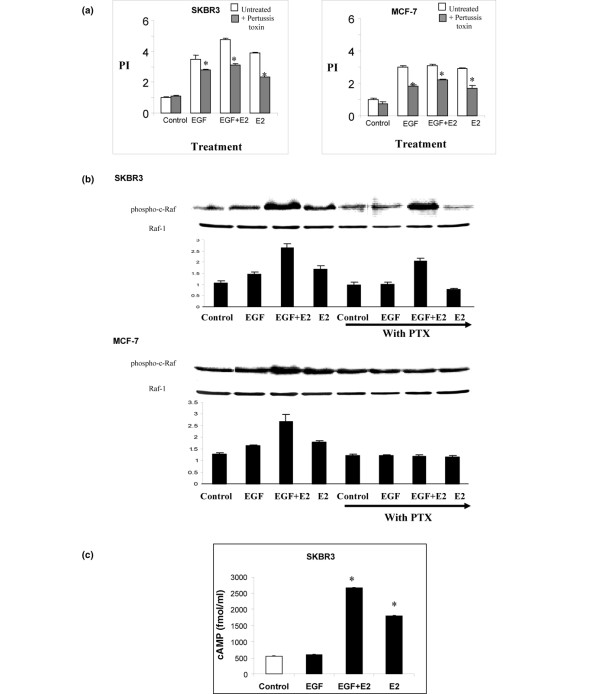
Effect of GPCR antagonism on 17β-oestradiol and EGF induced cell proliferation, Raf phosphorylation and cAMP production in breast cancer cells. (a) SKBR3 and MCF-7 breast cancer cells pretreated with or without the GPCR antagonist PTX (50 ng/ml) 1 hour before 24 hours of incubation EGF (10 ng/ml) and 17β-oestradiol (10-8 mol/l) alone and in combination. Cell proliferation assays were carried out using MTT thiozolyl blue. Proliferative index of the control group is standardized to 1. The results shown are expressed as mean ± standard error (n = 9). Statistical analysis was performed using Mann Whitney U test (*P < 0.02 versus without PTX). (b) Western blot analysis of phospho-Raf and total Raf in SKBR3 and MCF-7 cells pretreated with or without the GPCR antagonist pertussis toxin (50 ng/ml) for 1 hour before 10 minutes of incubation with EGF (10 ng/ml) and 17β-oestradiol (10-8 mol/l) alone and in combination. Results are representative of those obtained in three separate experiments. (c) Intracellular cAMP levels in SKBR3 cells treated with EGF (10 ng/ml) and 17β-oestradiol (10-8 mol/l) alone and in combination. Results are expressed as mean ± standard error (n = 9). Statistical analysis was performed using Mann-Whitney U test (*P < 0.02 versus control). E2, 17β-oestradiol; EGFR, epidermal growth factor receptor; GPCR, G-protein-coupled receptor; PI, proliferative index.